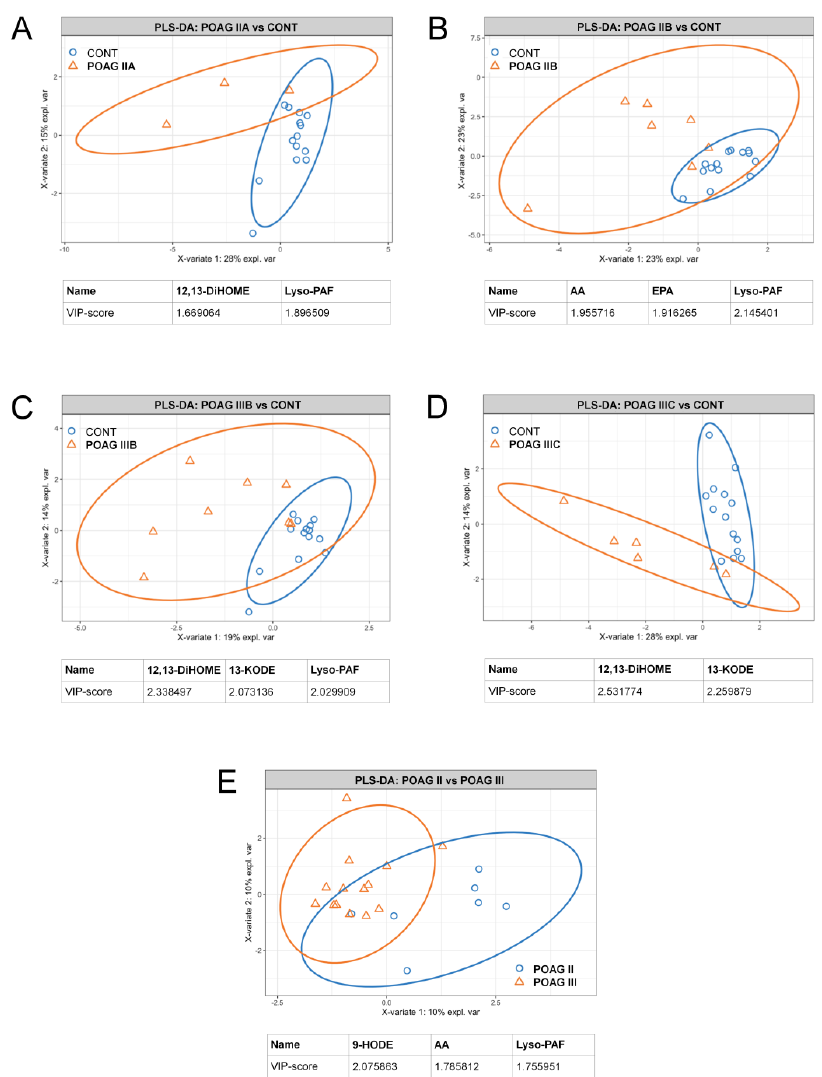
Figure 2. Stage/IOP-dependent alterations in the content of signaling lipids in AH of POAG patients. The results of partial least square discriminant analysis (PLS-DA) revealing AH compounds distin- guishing glaucoma patients with Stage IIA ( A ), Stage IIB ( B ), Stage IIIB ( C ) or Stage IIIC ( D ) POAG from the control individuals (CONT). The PLS-DA data regarding comparison of AH contents of signaling lipids in patients with different POAG stages regardless IOP levels are also presented ( E ). The explained variance of each component is indicated on the axes. Variable importance in projection (VIP) scores exceeding a cutoff value of 1.5 are